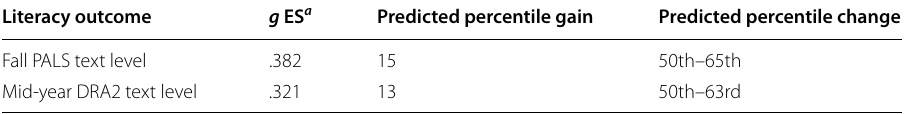
Table 4 Effect sizes and predicted percentile gain and change for first grade text-level reading ability related to Pre-K